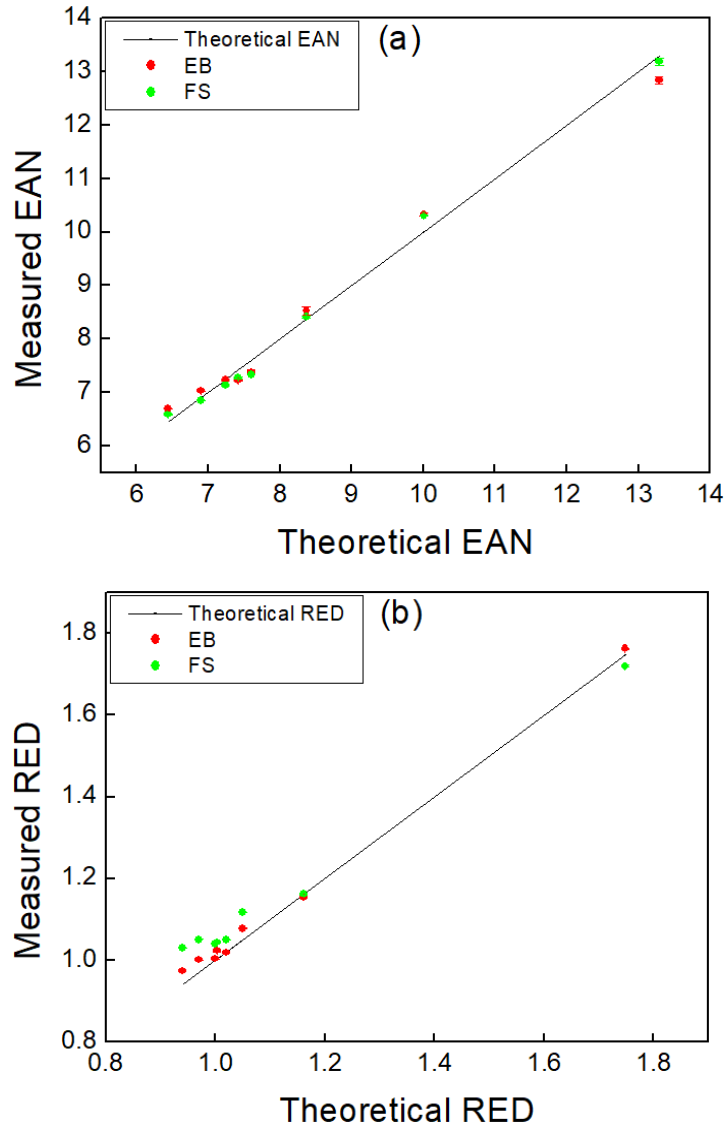
Figure 6. ( a ) Measured effective atomic number (EAN) and ( b ) relative electron density (RED) for energy bin (EB) and full spectrum (FS) modes. Mean errors of EAN for EB and FS are 2.48% and 2.04%, respectively. Mean errors of RED for EB and FS are 1.68% and 4.58%, respectively.